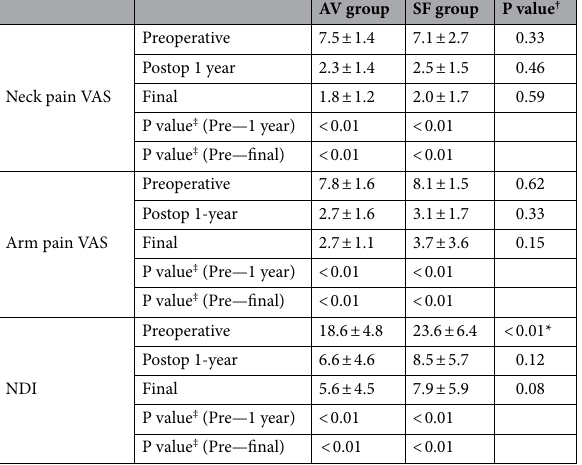
Univariate analysis Odds ratio Confidence interval P